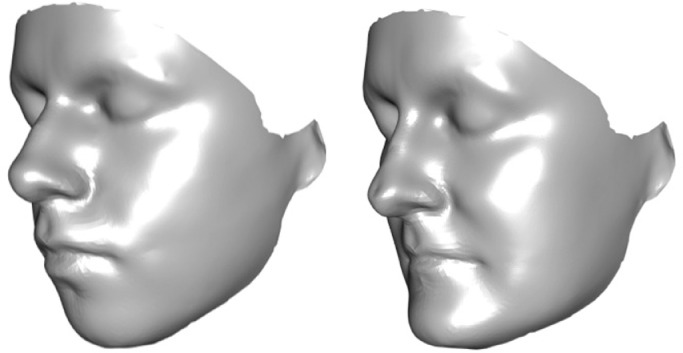
Visualization of PC1 of non-affine space as plain surfaces on coronal-sagittal oblique view for (left) control shape and (right) patient shape (each magnified × 3).